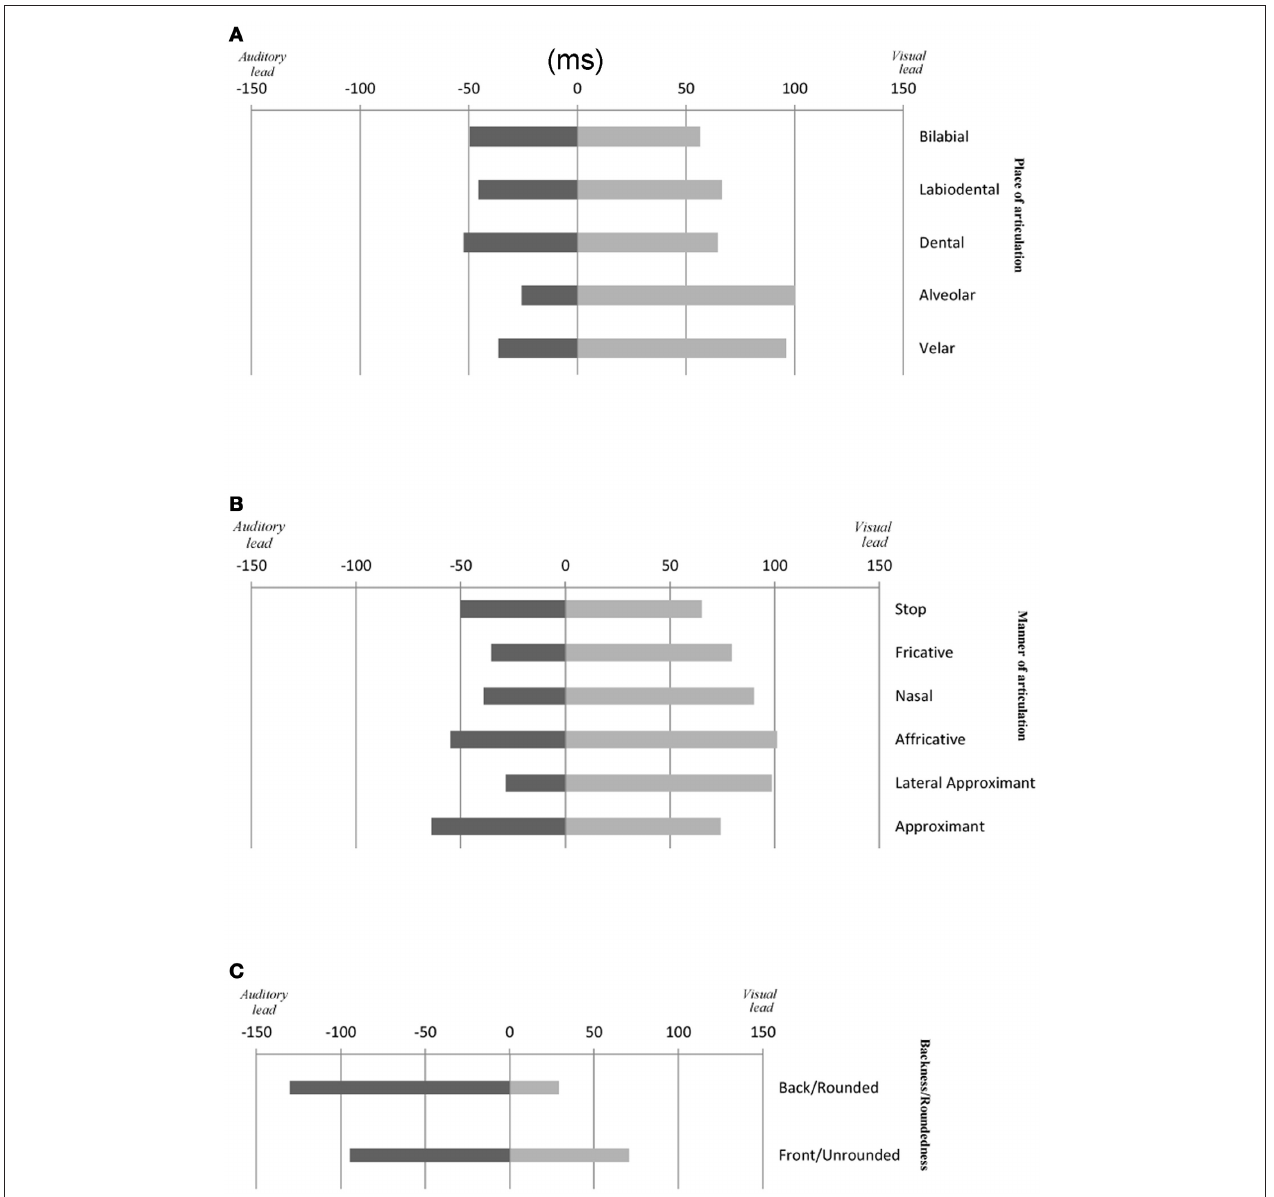
FIGURE 4 | Average temporal window of integration (PSS ± JND) for audiovisual speech as a function of: (A) the place of articulation and (B) the manner of articulation of consonant and (C) backness/roundedness of vowel stimuli used in this